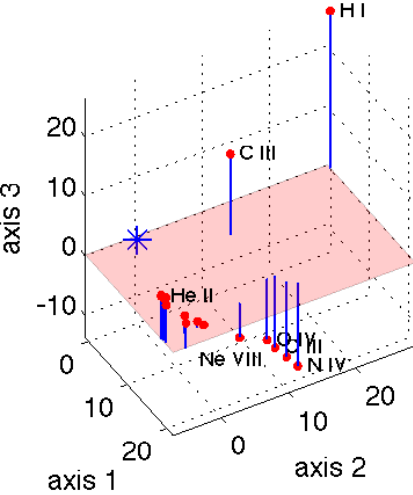
Fig. 9. Same plot as Fig. 8d, after normalizing each quantity to its standard deviation.